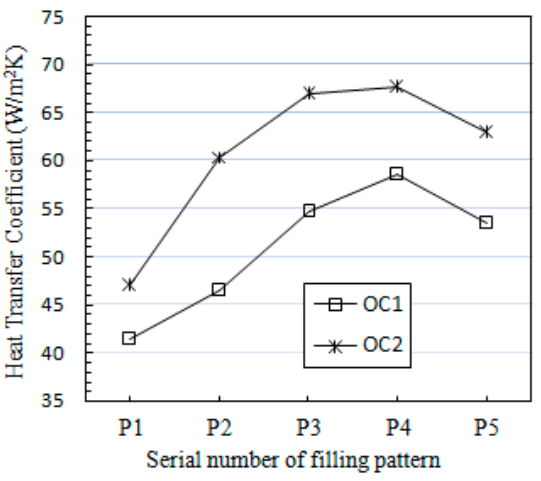
Figure 3. Relationship curves between heat transfer coefficient and filling layout patterns. OC1: Operating conditions 1 (50 ◦ C, 6 L/min); OC2: Operating conditions 2 (60 ◦ C, 6